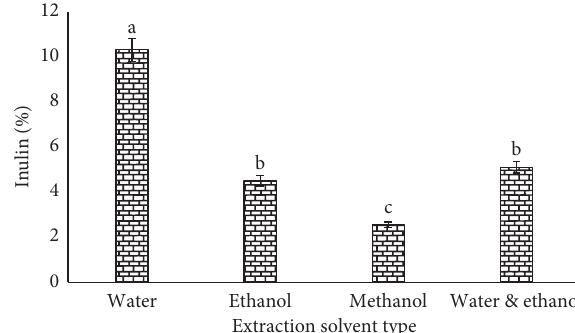
Figure 1: Comparison of mean inulin extraction yield by different solvents in maceration